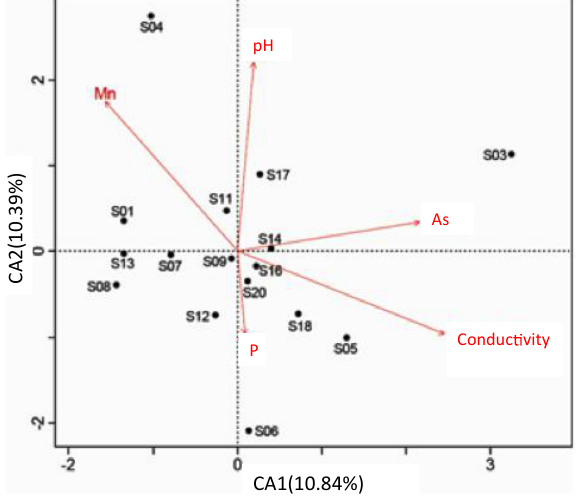
Figure3. Figure 3. Canonical correspondence analysis of microbial data and the subset of environmental variables.